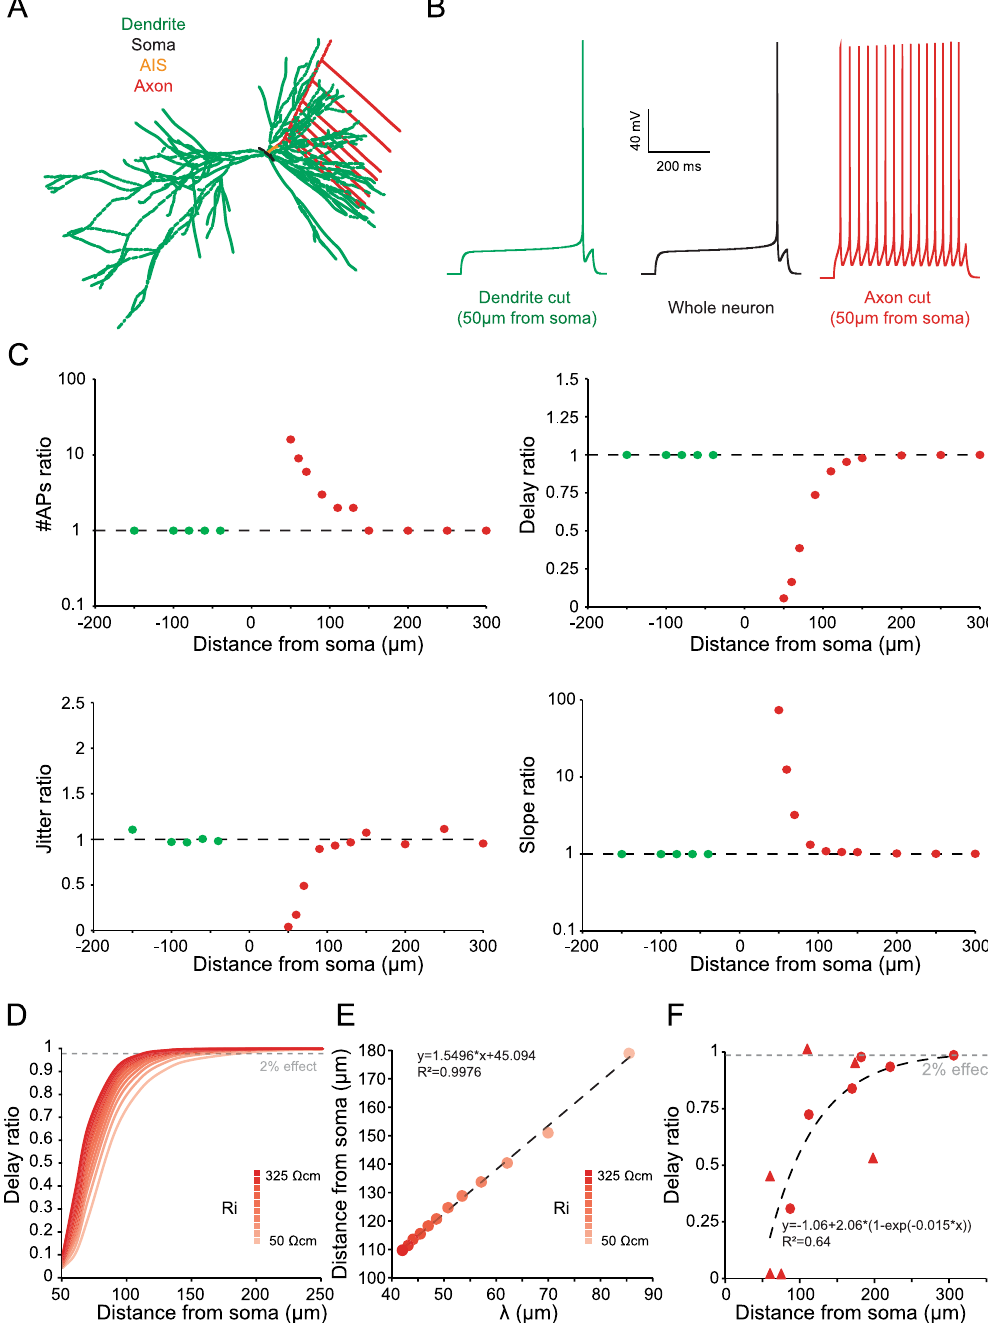
focally has an effect only on the axon initial segment but not on the cell body 13 . However, in these studies it was not clear whether the excitability of the cell measured in the cell body was influenced by Kv1 channels located far- ther than the AIS. We show here that axonal Kv1 channels located beyond the AIS control the excitability of CA3